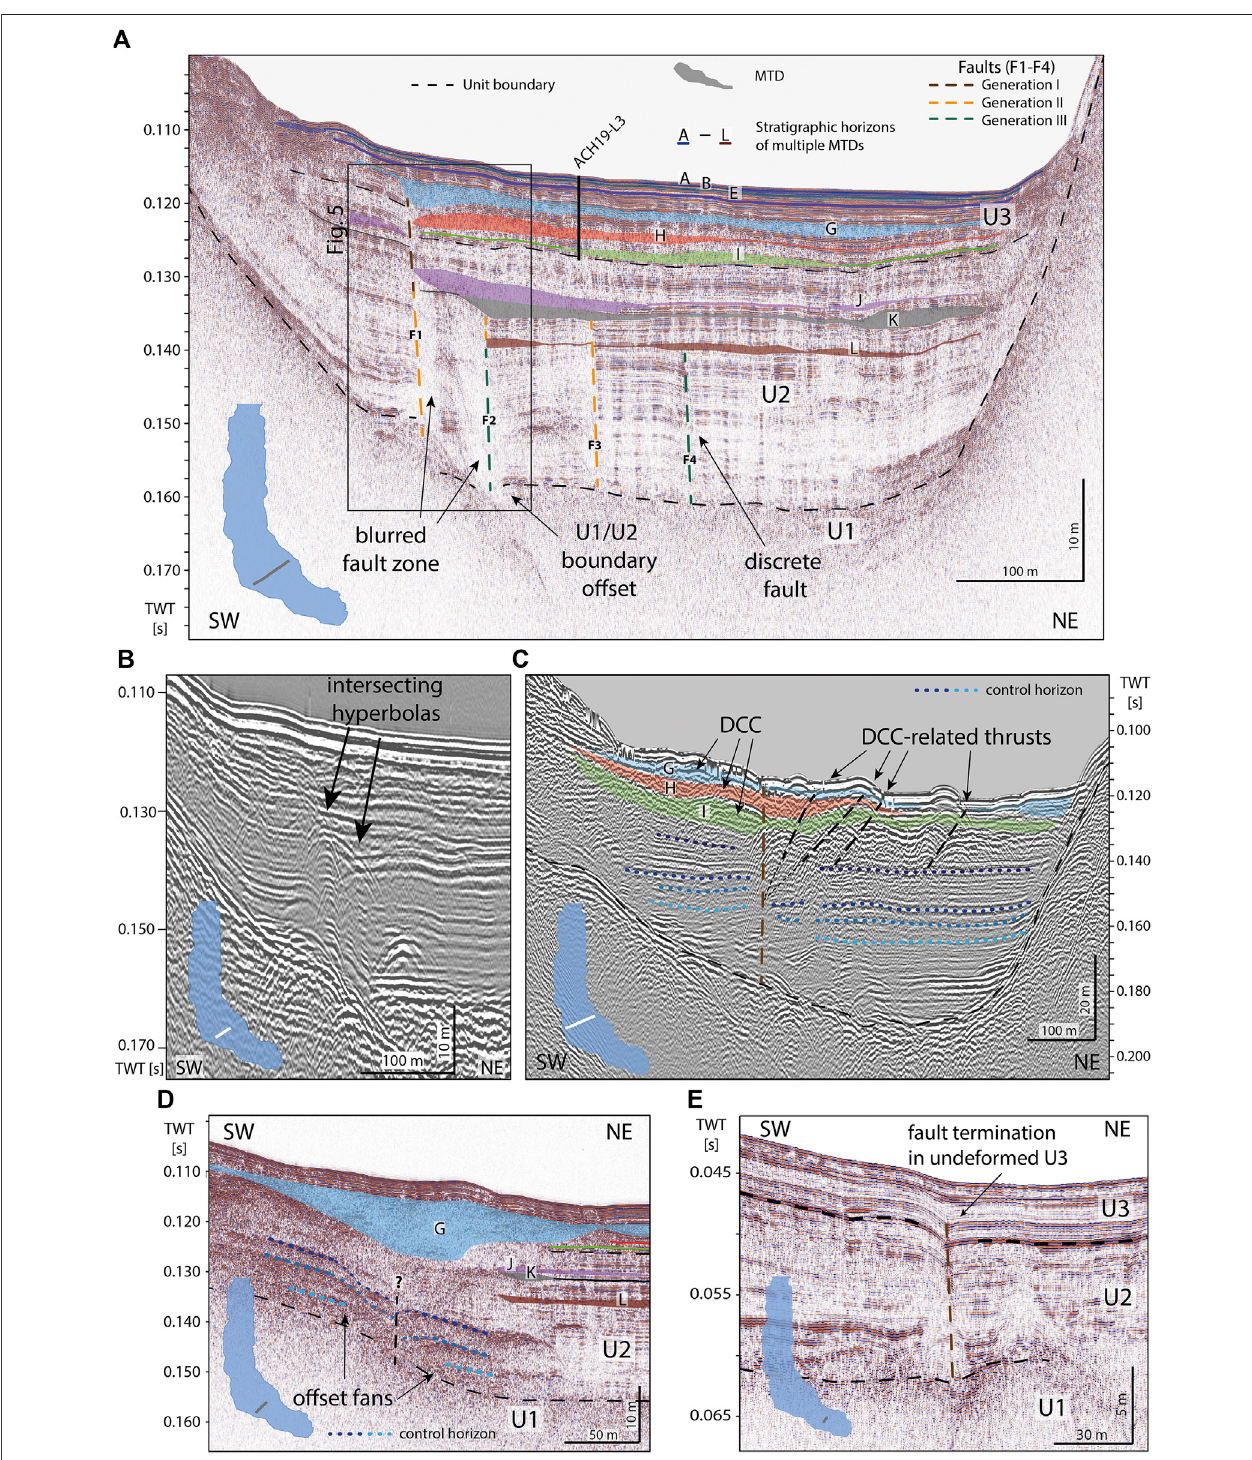
FIGURE 4 | Seismic pro fi les across the Pertisau basin with interpretation of both on-fault and off-fault paleoseismic evidence. Locations of the seismic pro fi les are indicatedbytherespectiveinset. (A) Pingerpro fi lewithfourfaultsexpressedasblurredzonesordiscreteoffsets,whicharesubdividedinfaultinggenerationsI,IIandIIIbased onthestratigraphiclevel oftheir uppertermination. EventhorizonsA-L depictstratigraphichorizonswithmultipleMTDs. The upperterminationoffault generations I,IIand III are directly overlain by MTDs of event horizons G, K and L. Vertical black line displays projected depth of core ACH19-L3 ( Figure 9 ). (B) Fault zone expressed by intersectinghyperbolasinasparkerpro fi le. (C) Ablurredfaultzoneoffsettingseismic-stratigraphiccontrolhorizons(dark-tolightblue)inasparkerpro fi le.Thefaultterminates